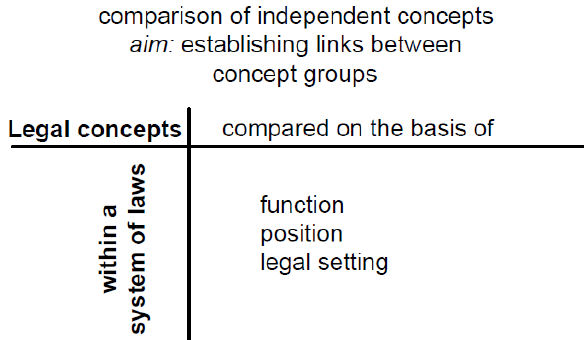
Figure 1. Functional comparative analysis according to Sandrini (1996: